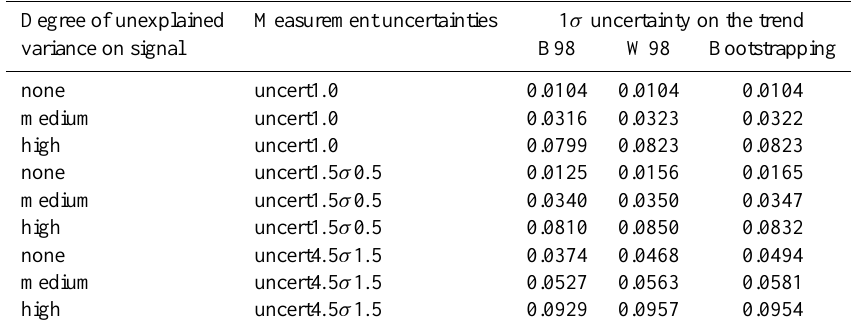
Table 1. The mean 1 σ uncertainties of the 500 trend values derived for the B98, W98 and bootstrapping approaches. For more details see